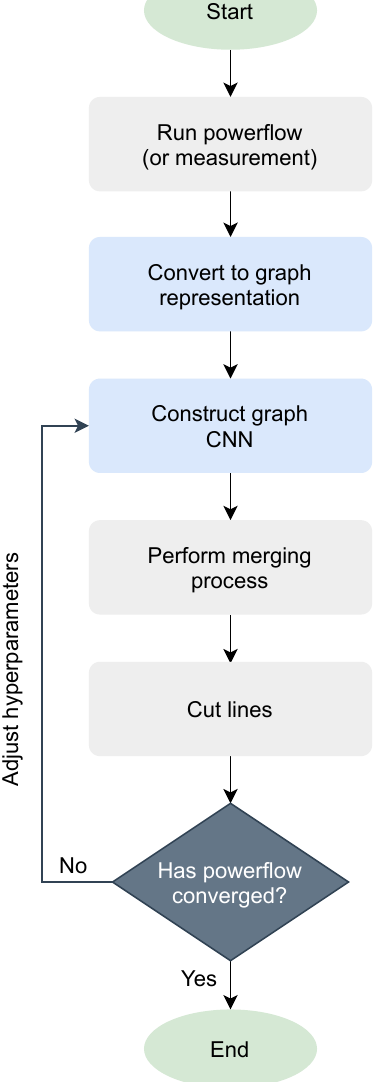
Figure 1. Flow chart depicting the proposed pipeline of the method for intentional